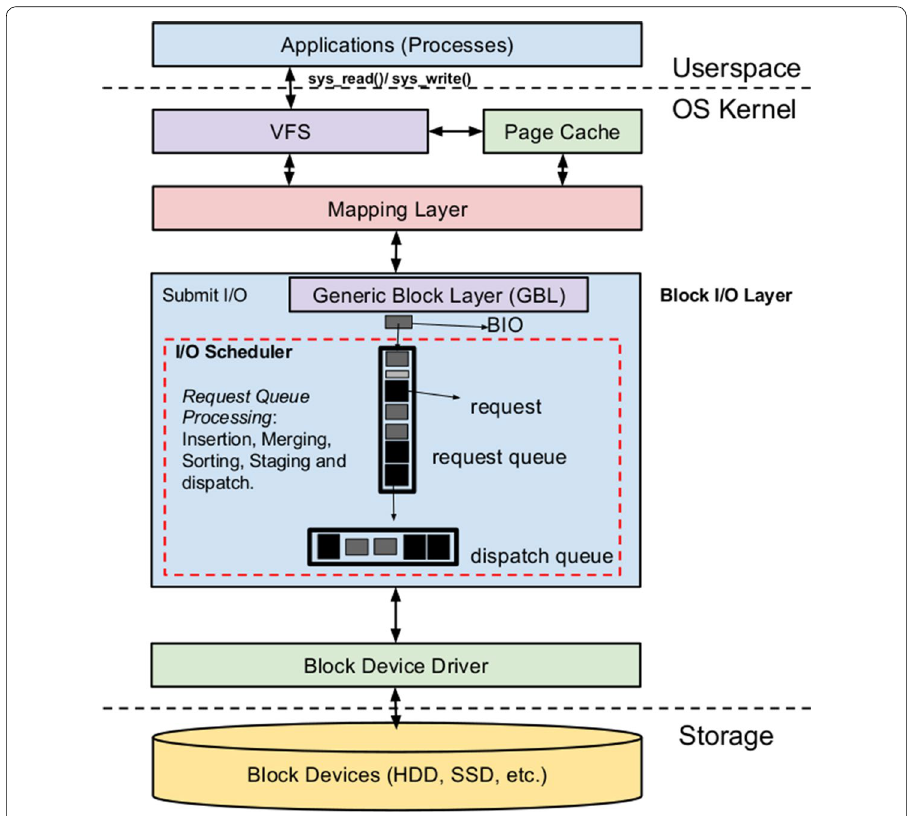
Fig. 2 Architecture of Linux Kernel I/O